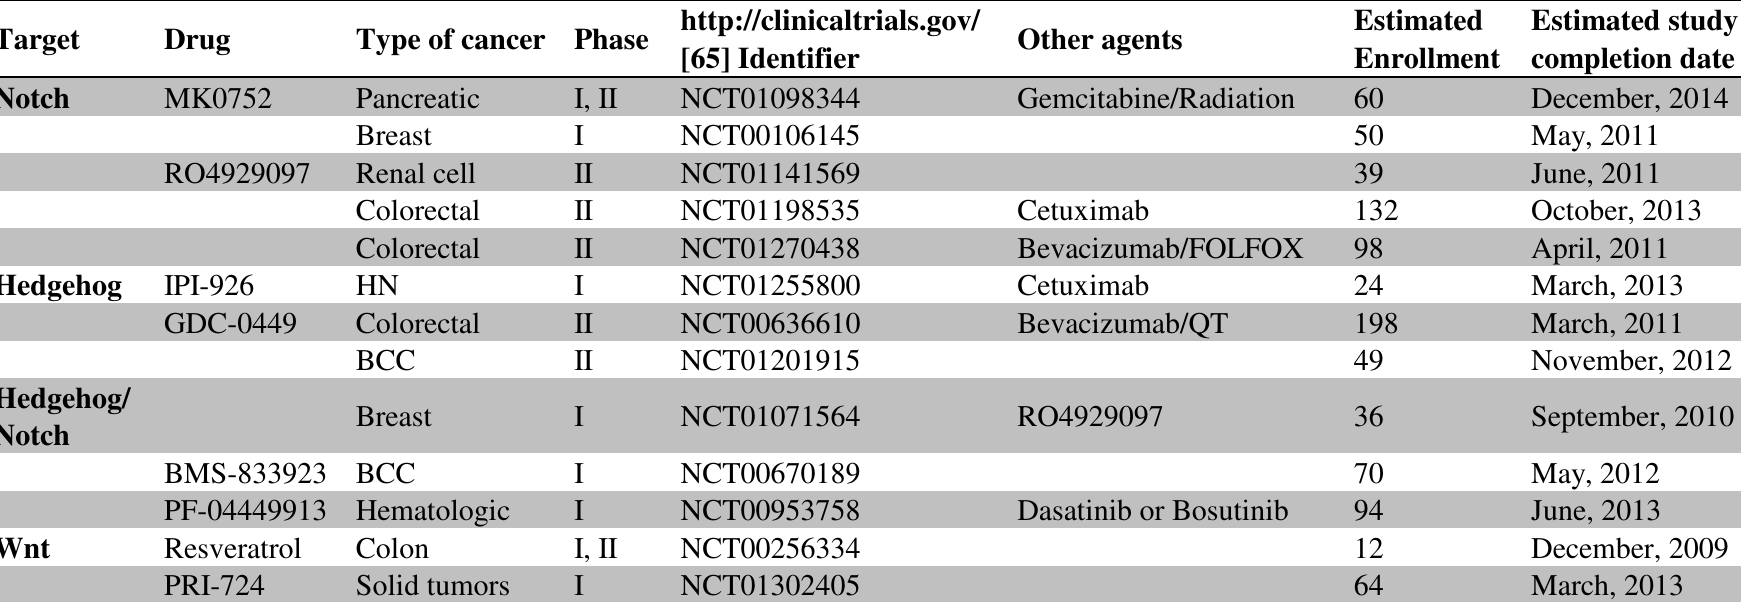
Table 1. Update on clinical trials for CSC molecular